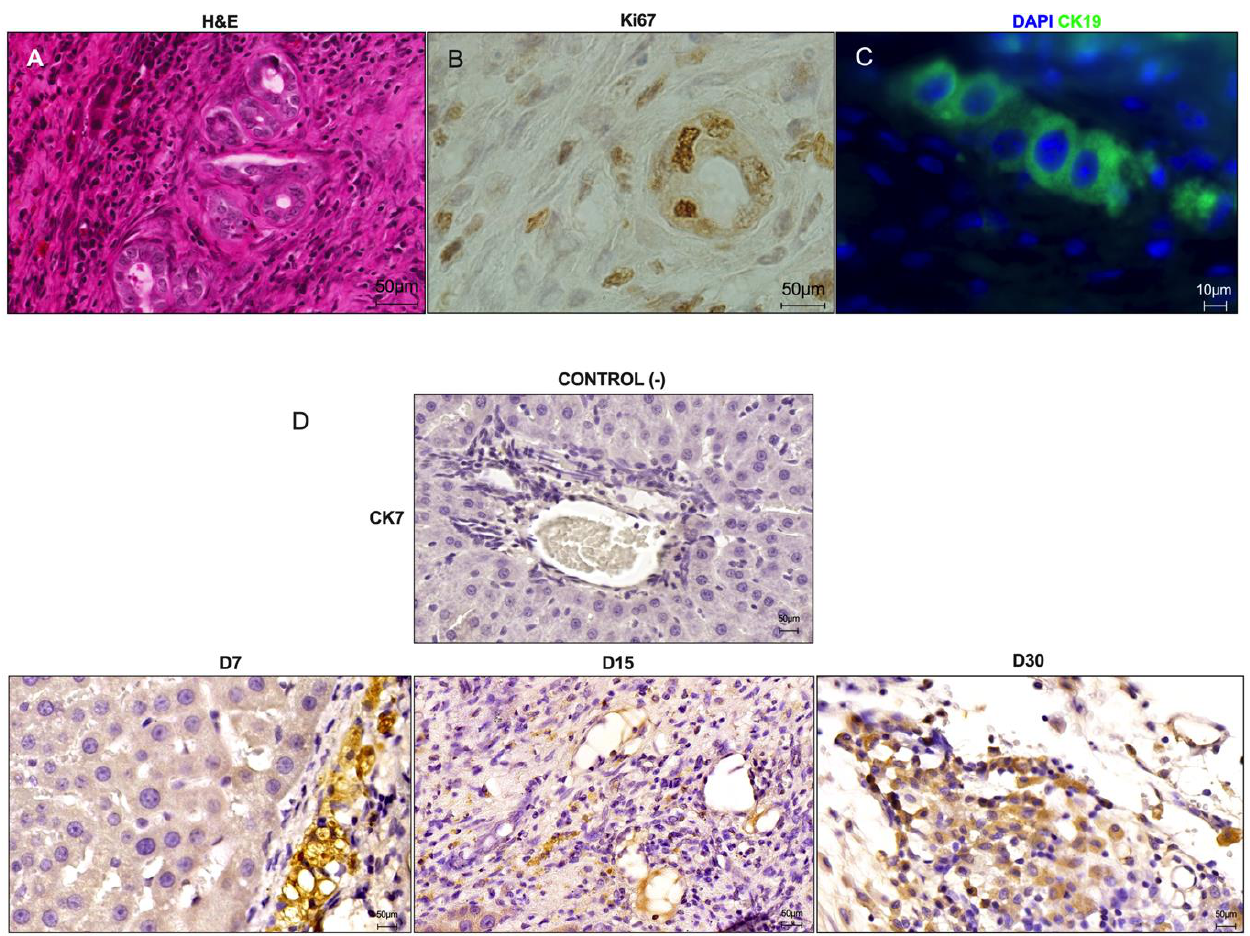
Figure 10. Intense bile duct proliferation contributes to ALS recellularization after transplanta- tion in cirrhotic rats. Histological sections stained with H&E show intense bile duct proliferation 7 days after ALS transplantation ( A ). Ki67 immunostaining shows proliferating cells in the bile duct structures 7 days post-transplantation ( B ). CK19-positive cells were distributed in ALS 30 days post- transplantation (scale bar: 10 μm) ( C ). CK7 immunostaining revealed bile duct structures at 7 and 15 days post-transplantation. CK7-positive cells were distributed in the ALS parenchyma 30 days post-transplantation ( D ). Scale bars: 50 μ